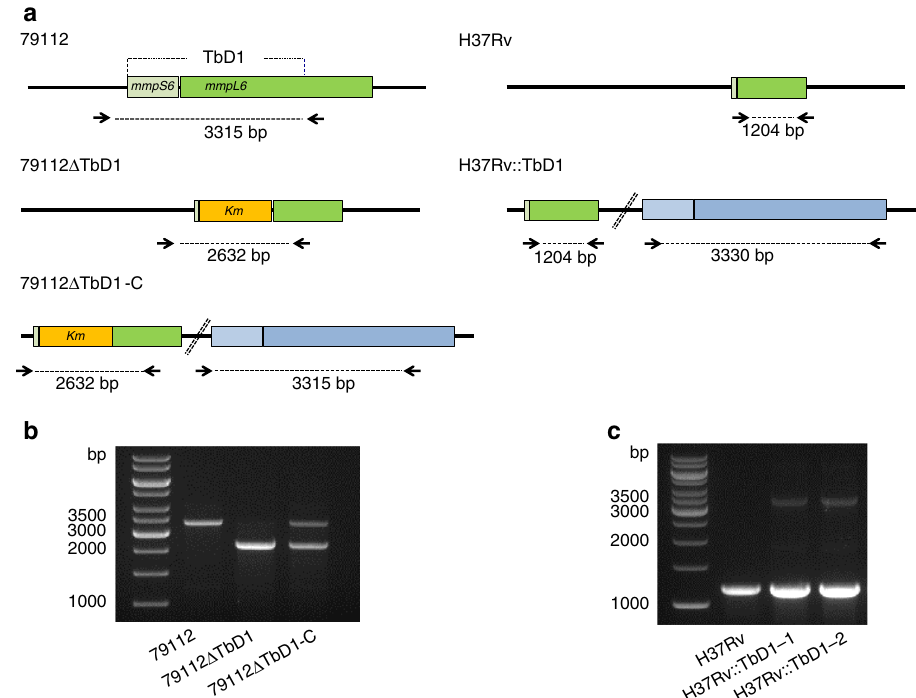
Fig. 3 Deletion and integration of the TbD1 locus in the 79119 and H37Rv genetic backgrounds, respectively. a Schematic representation of the genomic organization of the TbD1 locus in the 79112 Δ TbD1 mutant and complemented strain (79112 Δ TbD1-C). The schematic representation of the genomic organization of recombinant H37Rv strains, harboring an intact TbD1 locus is also depicted. Arrows indicate primers used in PCR reactions. b , c Ampli fi cation pro fi les obtained in PCR reactions performed on genomic DNAs from different Mtb strains by using primer pairs, speci fi c for TbD1 fl anking region. The 2632 bp-fragment obtained in 79112 Δ TbD1, or the 2632-bp and 3315-bp ampli fi cation products detected in 79112 Δ TbD1-C con fi rmed the TbD1 deletion and its replacement by a kanamycin resistance gene in the 79112 Δ TbD1 mutant, the correct TbD1 deletion/re-integration in the 79112 Δ TbD1-C complemented derivative strain, respectively ( b ). Similarly, the 1204-bp product obtained in H37Rv, or the 1204-bp and 3330-bp fragments observed in H37Rv::TbD1 clones correspond to the TbD1-deleted locus originally present in WT H37Rv and to the full-size TbD1 region ( mmpS6/mmpL6 ) integrated into the genome, respectively ( c